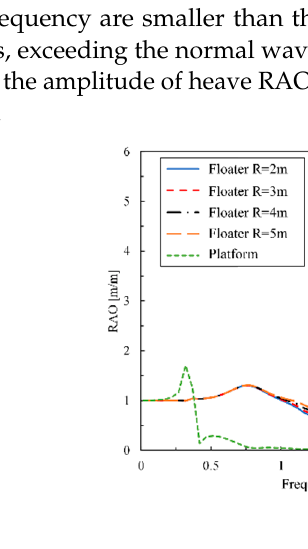
Figure 4. Comparison of device layout with floater RAO with different radii: ( a ) overall mooring layout; ( b ) RAO of floater with different radii floating freely in 0 wave direction.